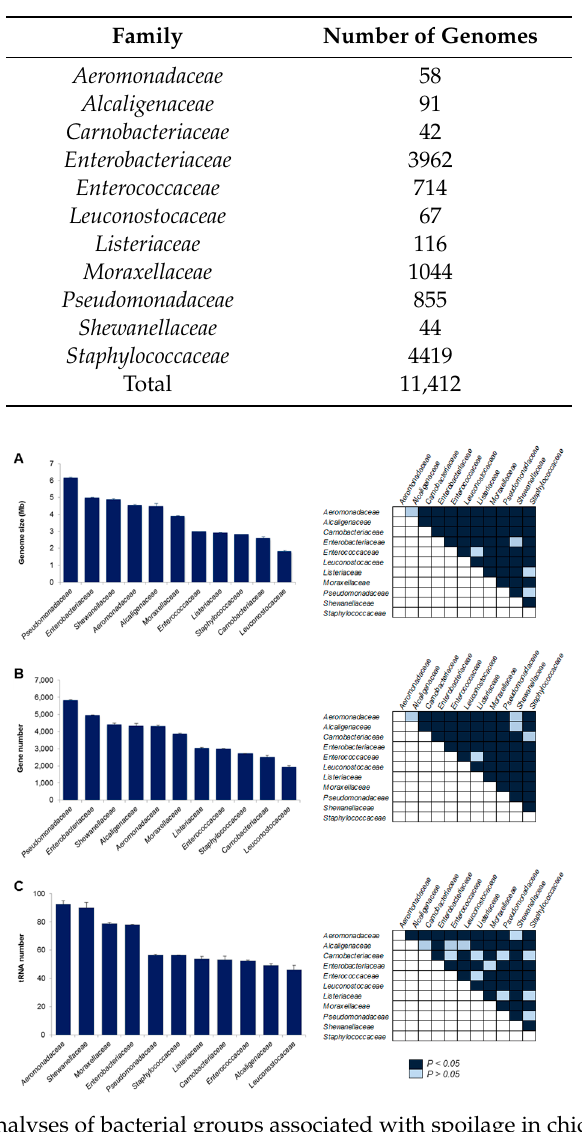
Figure 1. Genomic analyses of bacterial groups associated with spoilage in chicken meat. A total of 11,412 bacterial genomes comprising 11 bacterial families were analyzed to estimate ( A ) genome size, ( B ) number of genes, and ( C ) number of tRNA genes. ( Left ) Graphs depict mean values and its standard errors. ( Right ) Pairwise matrix showing p values estimated by means of ANOVA Fisher’s protected least significant difference test.